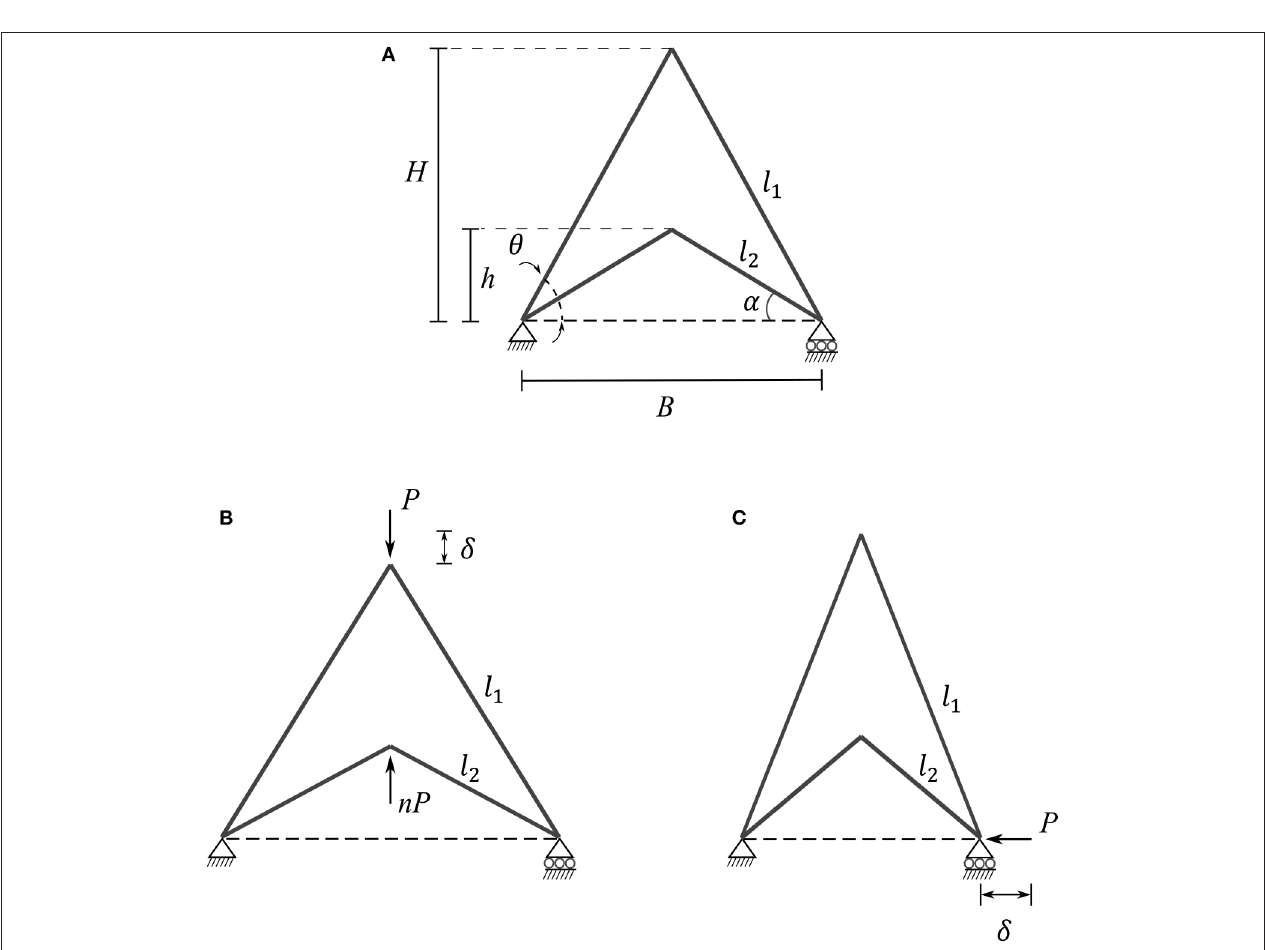
FIGURE 5 | Unit cell of the arrowhead geometry under two different loading conditions. (A) Definitions of angles and lengths of the unloaded cell; (B) two opposing vertical loads P and nP applied at the top and bottom vertices and (C) a horizontal load P applied at the roller